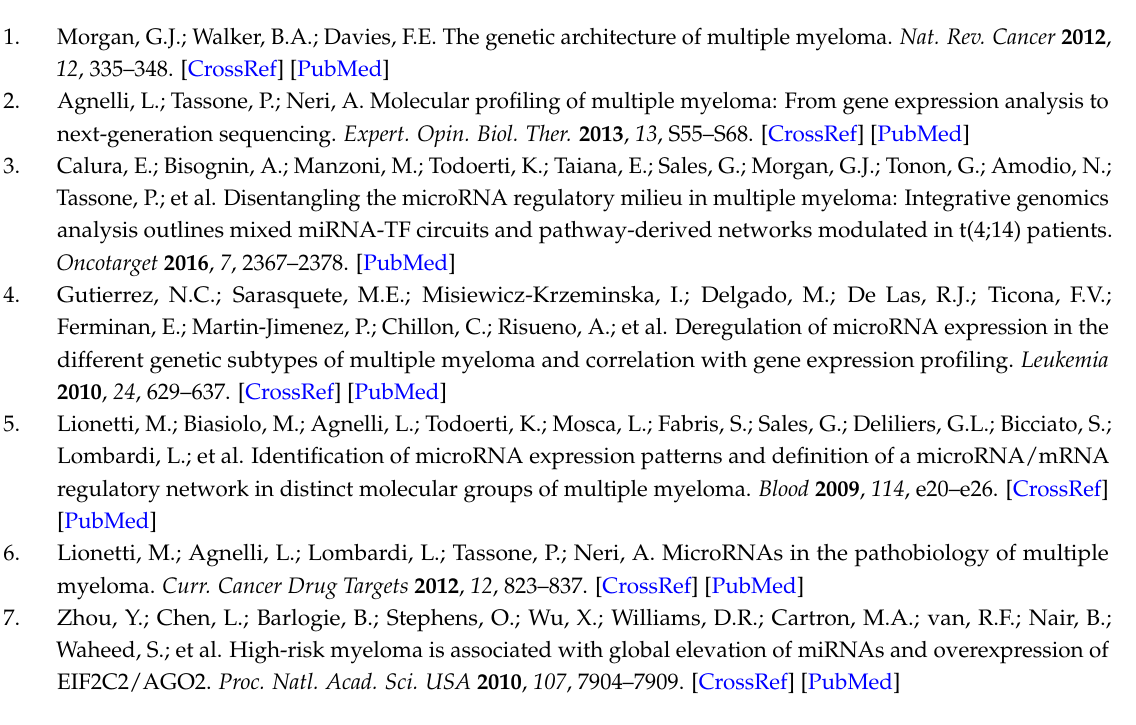
Table S1: List of selected relevant miRNAs and